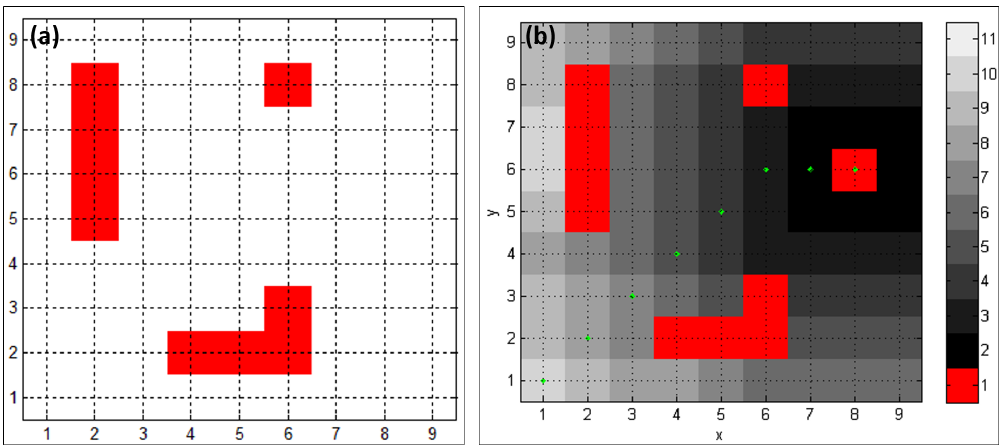
Figure 15. The library grid map utilized for robot route planning experiments. ( a ) A 9 × 9 grid map established for the lab space; ( b ) The robot route established with D ∗ Lite